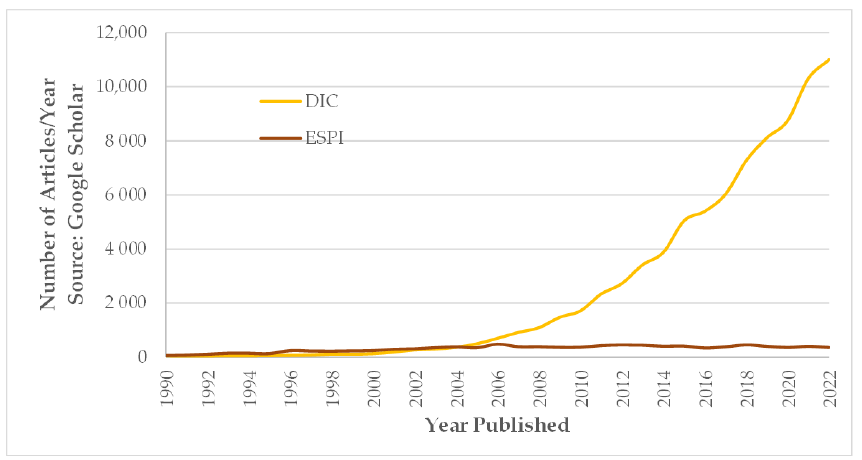
Figure 1. Increasing use of the DIC technique in scientific publications (on the basis of Google Scholar).